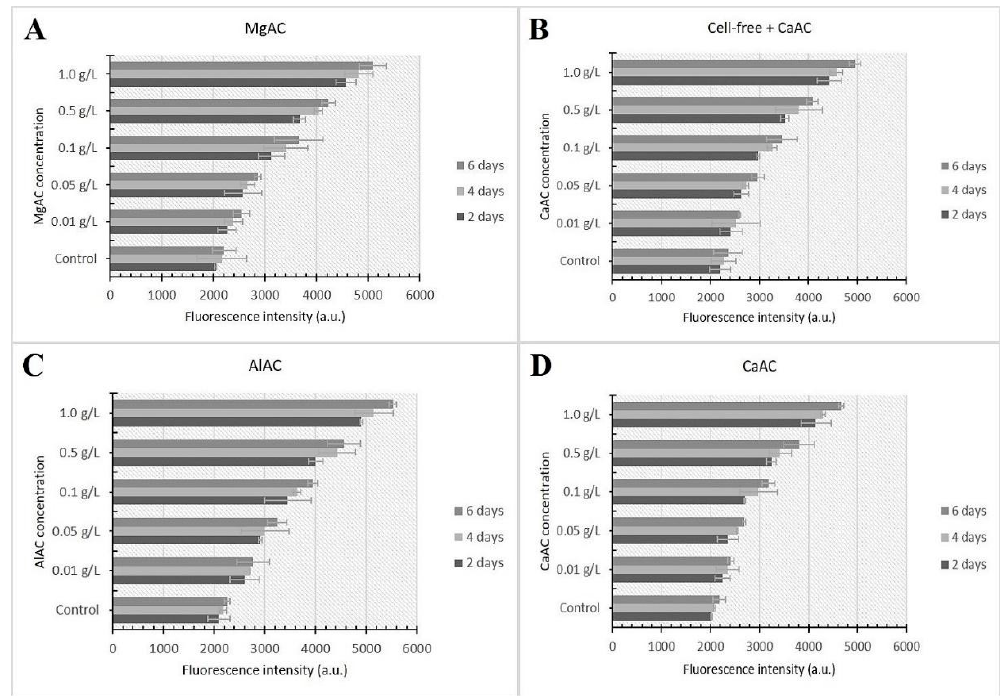
Figure 3. ROS formation in cyanobacterial co ‐ culture according to different concentrations (0.01, 0.05, 0.1, 0.5, and 1.0 g/L) of ( A ) MgAC, ( B ) CaAC in cell ‐ free medium/CaAC, ( C ) AlAC, and ( D ) CaAC. The standard deviations of the mean ( n = 3) are represented by the error bars. A p < 0.05 value is considered to represent significant difference.